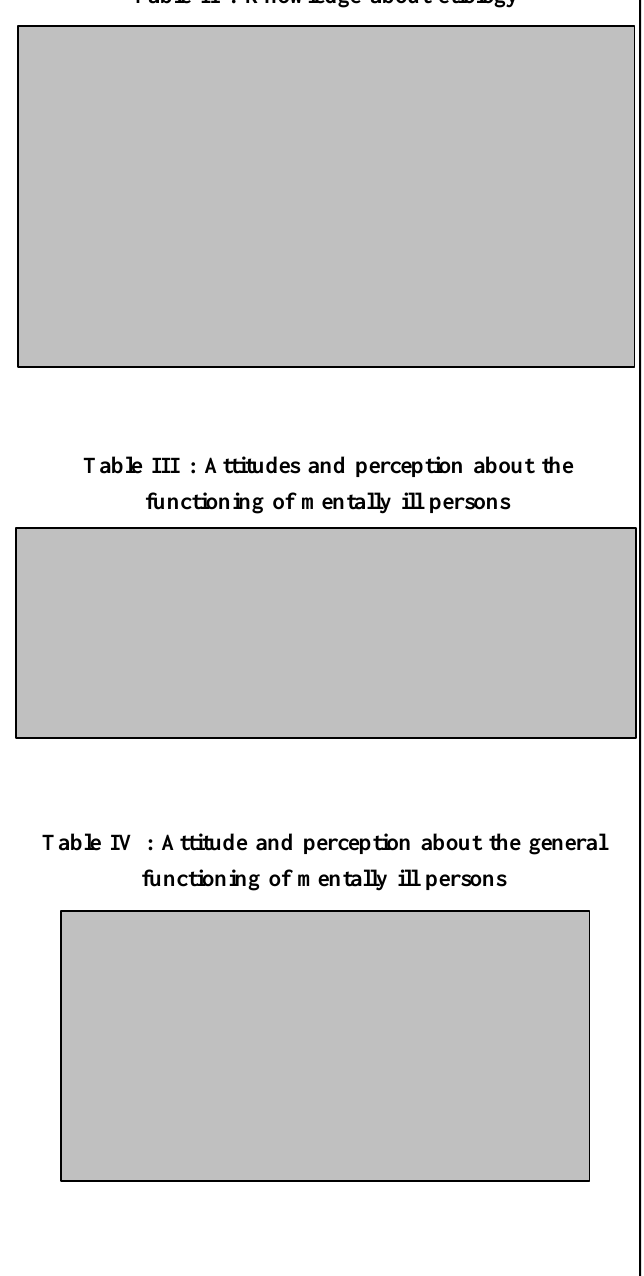
Table II : Knowledge about etiology